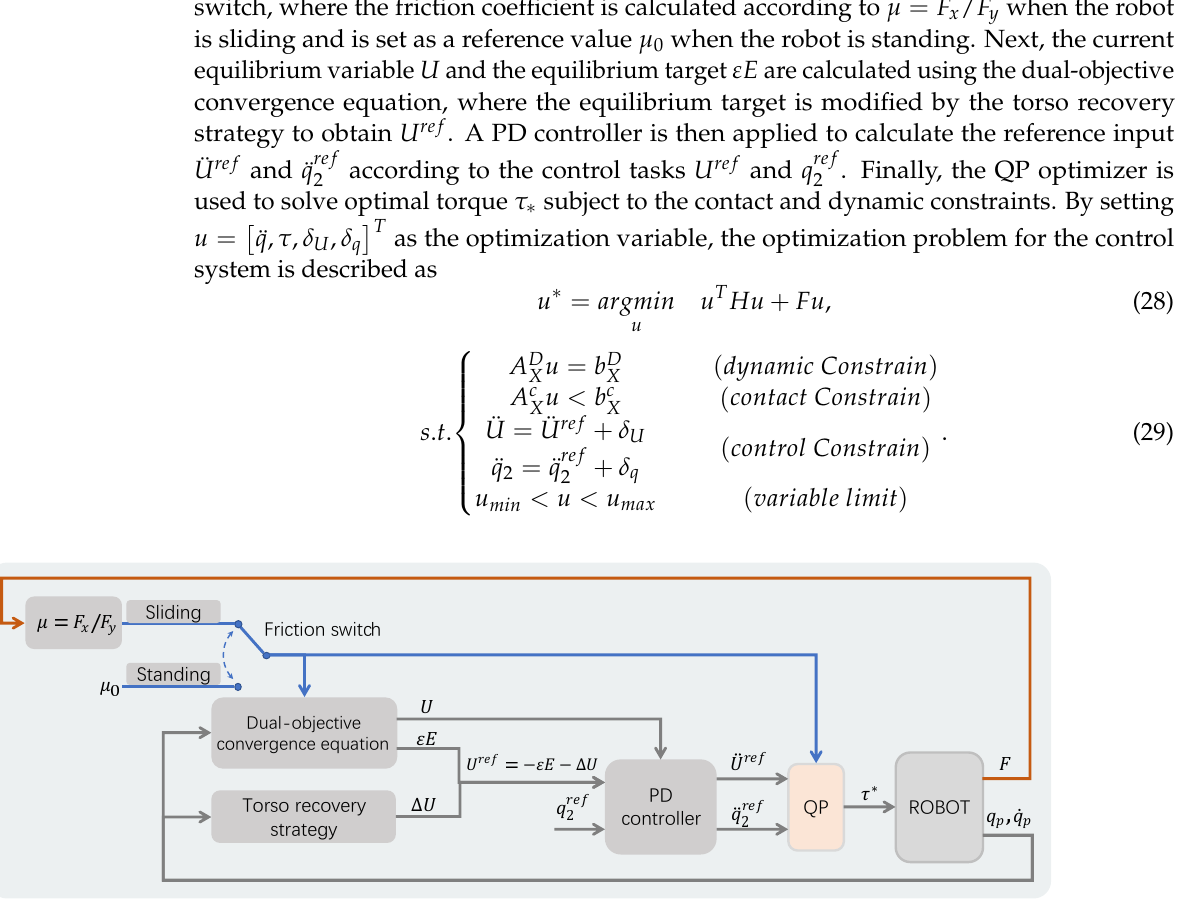
Figure 4. Robot control